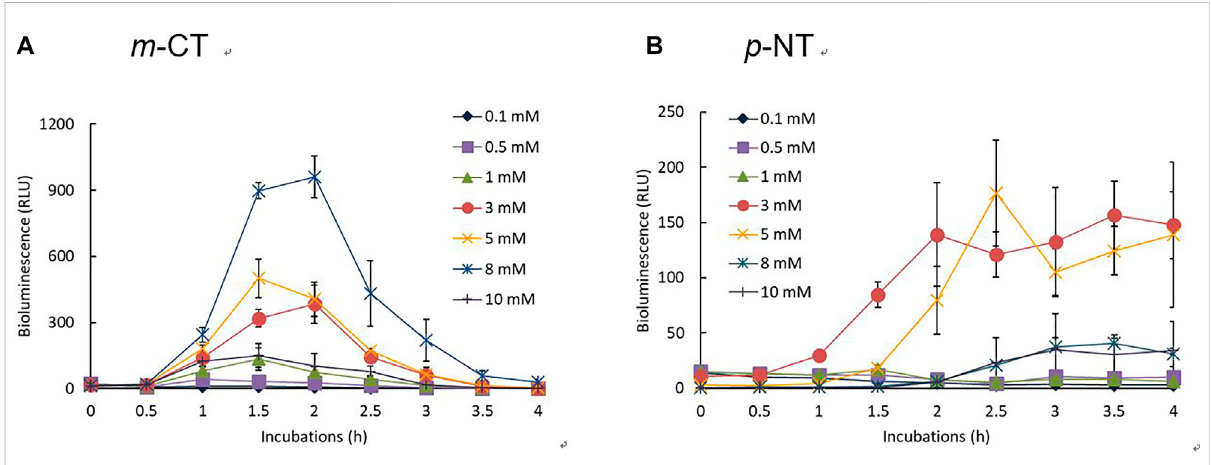
FIGURE 2 Two representative results of the pro fi les of the bioluminescence activities of KG1206 with different concentrations of m -CT (A) and p -NT (B) over